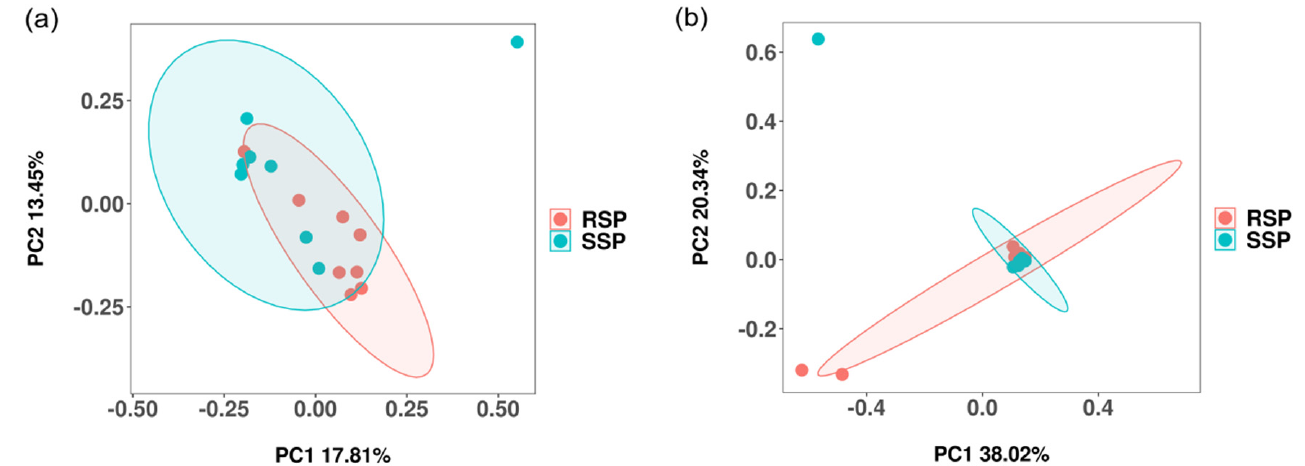
Figure 1. The PcoA based on the Bray–Curtis distance showing the variation in the bacterial ( a ) and the fungal ( b ) community structure. Different colors represent the samples from different groups. SSP and RSP groups. For the bacterial community, there were 1724 shared OTUs, and 567 unique OTUs in the RSP group and 523 unique OTUs in the SSP group, respectively (Figure 2a). For the fungal community, there were 930 shared OTUs, 372 unique OTUs in the RSP group and 351 unique OTUs in the SSP group, respectively (Figure